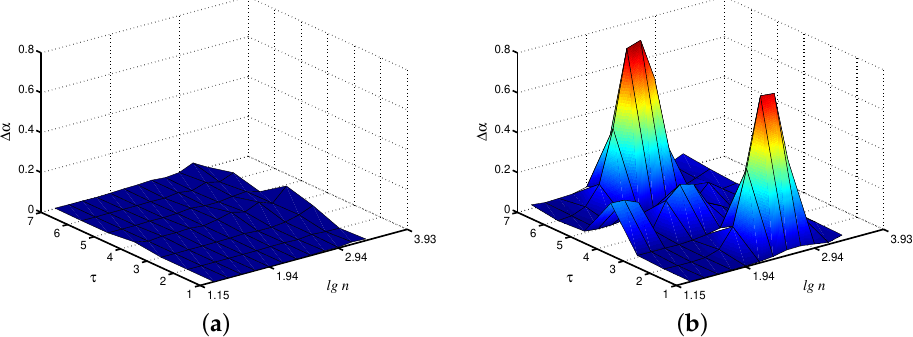
Figure 4. Differences ∆ α in local values of α for both interacting units (fast mode) for synchronous ( a ) and asynchronous ( b ) chaotic